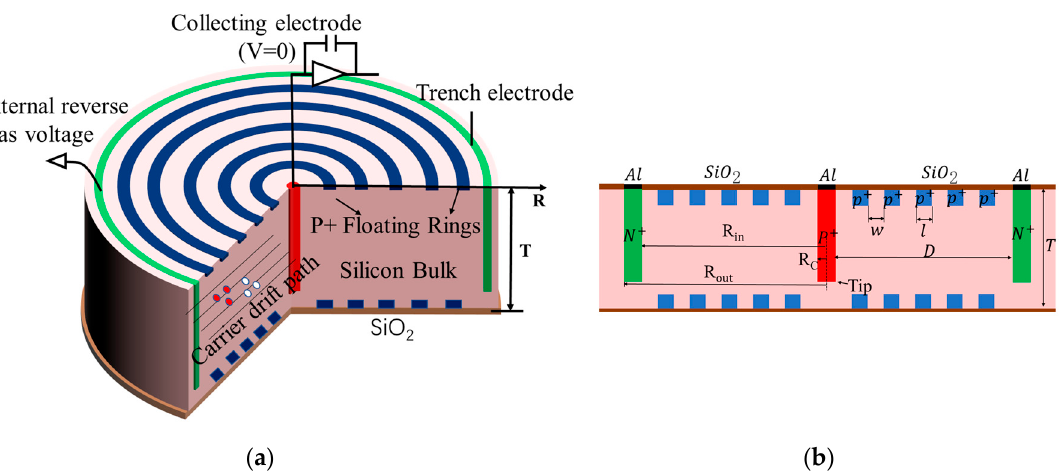
Figure 1. Structure diagram: ( a ) 3D large-area trench electrode silicon detector with multiple floating rings; and ( b ) longitudinal cross-section.